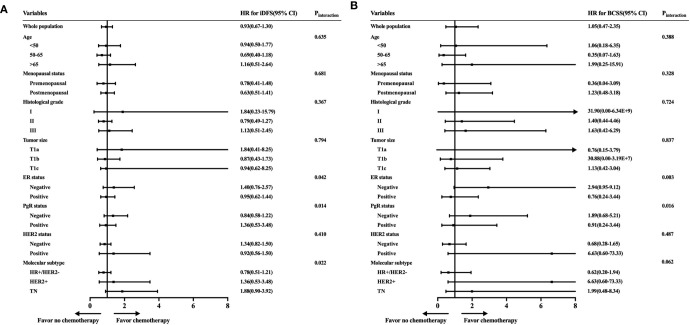
Exploratory analyses of invasive disease-free survival (iDFS) and breast cancer-specific survival (BCSS) rates according to patient characteristics and tumor subtype. (A) Forest plot of the hazard ratios of the iDFS rates of patients receiving chemotherapy compared with patients not receiving chemotherapy. (B) Forest plot of the hazard ratios of the BCSS rates of patients receiving chemotherapy compared with patients not receiving chemotherapy.